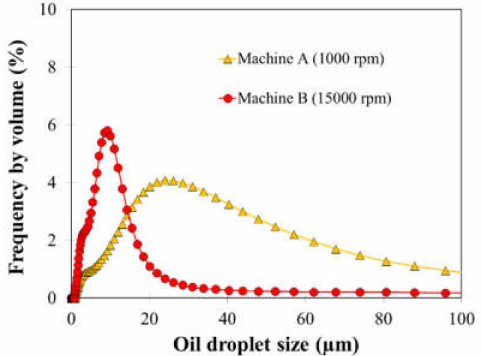
Figure 2. Size distribution of oil droplets in suspension (1 wt.% of kerosene and 99 wt.% of distilled water) prepared using machine A (1000 rpm) and B (15,000